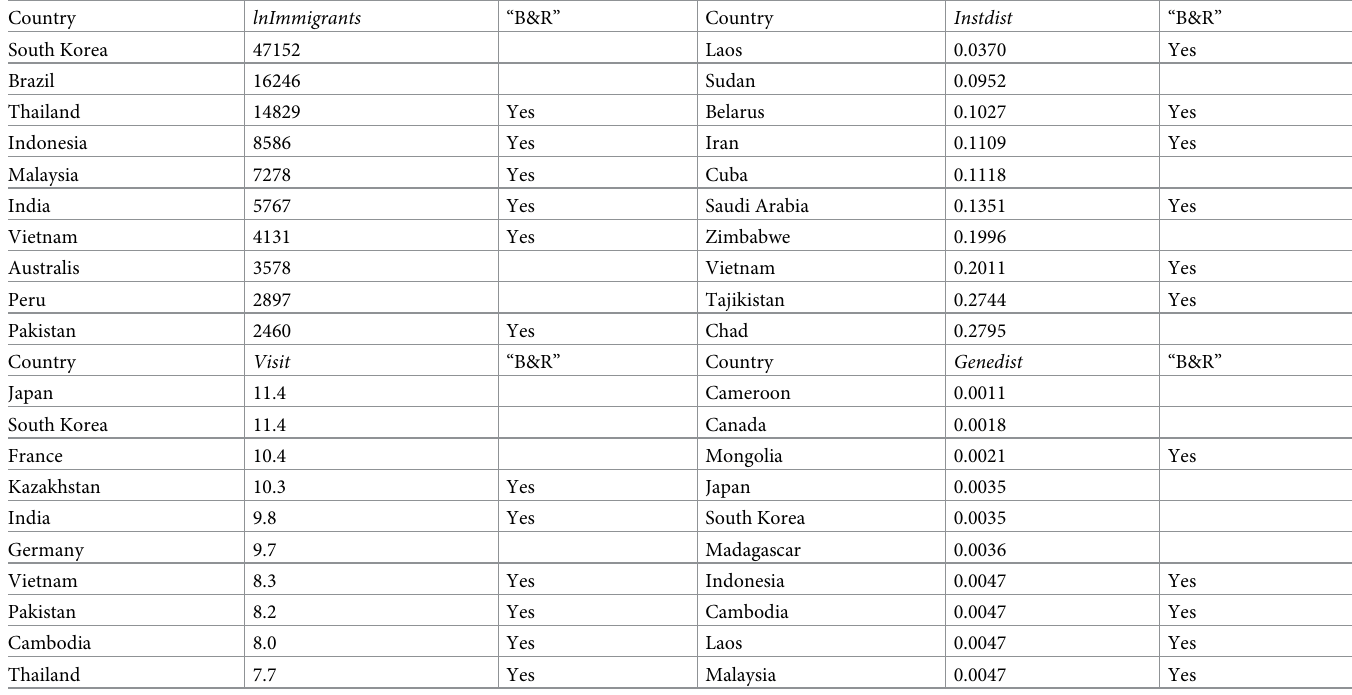
Table 10. Comparative analysis of “intimate” relations across countries.